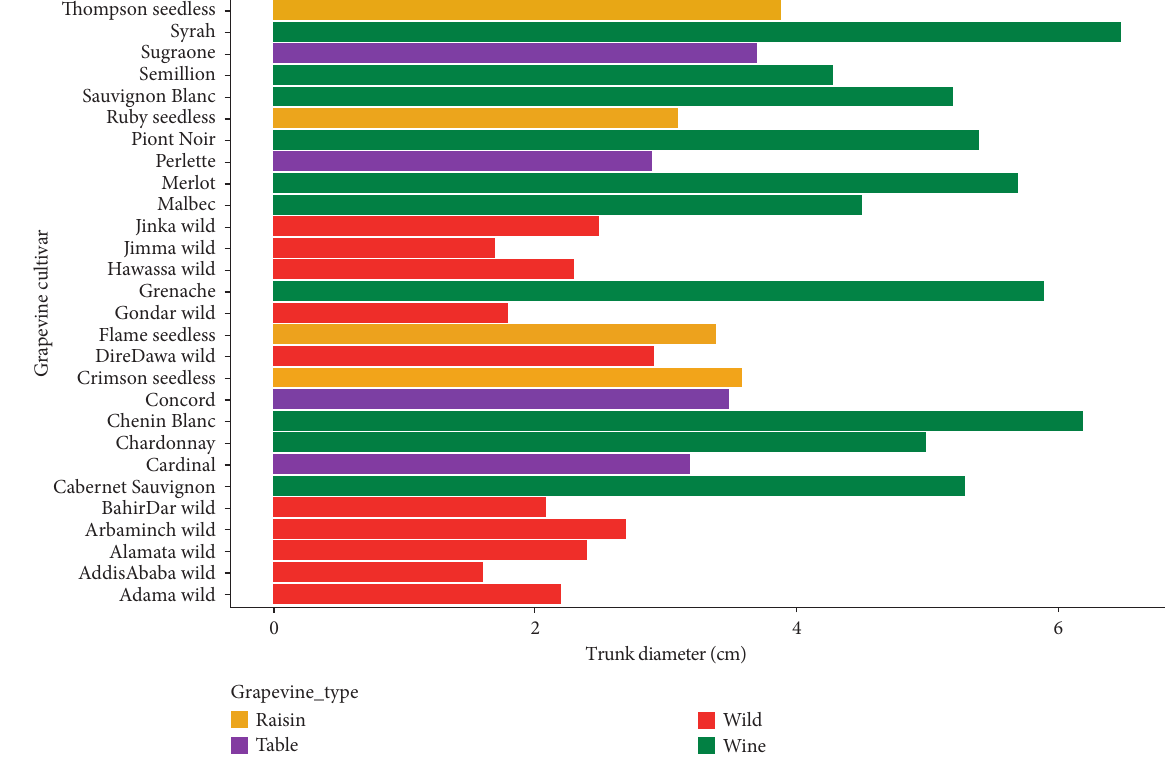
Figure 3: Trunk diameter in grapevine cultivars and grapevine types.